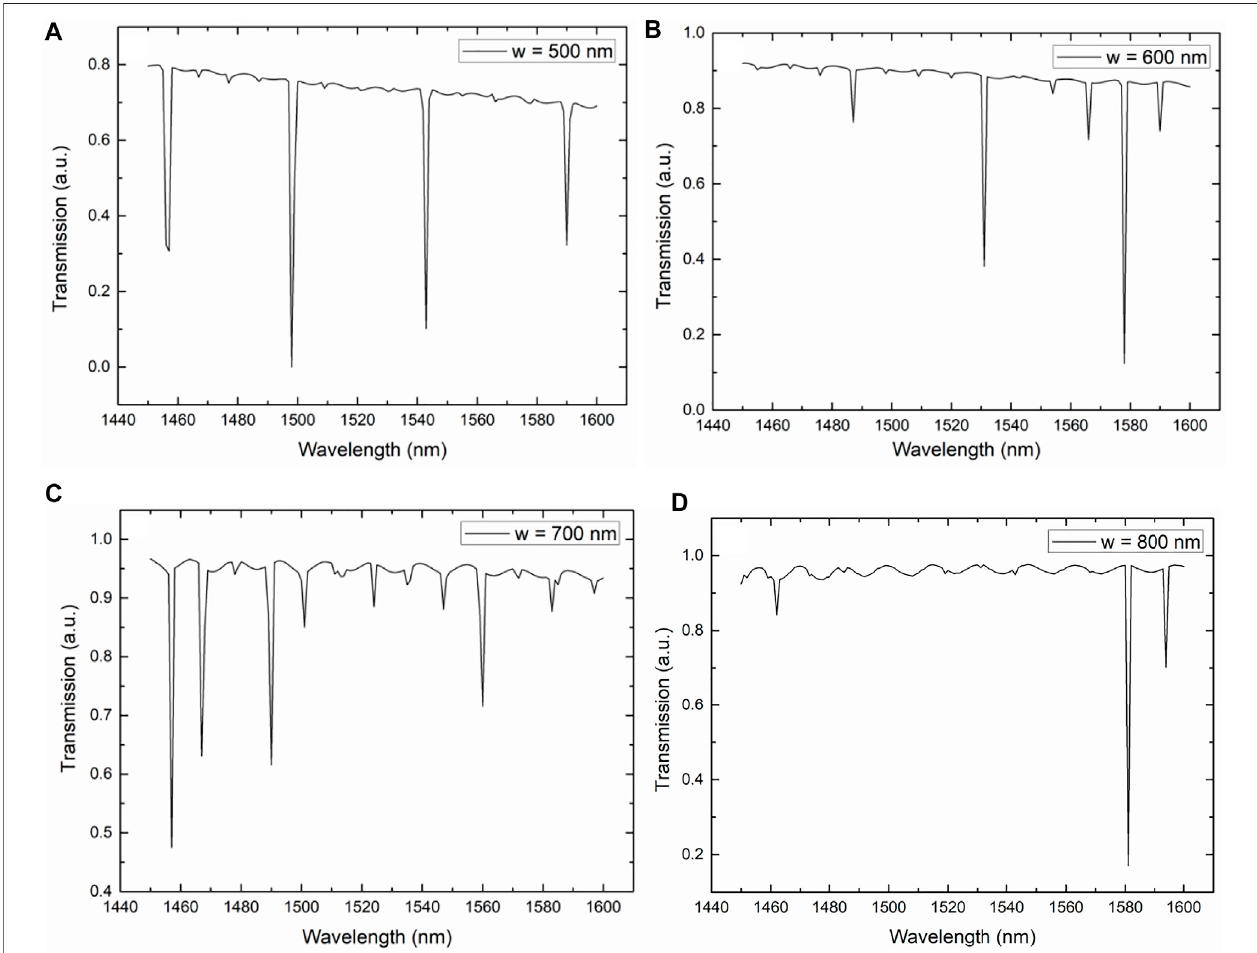
FIGURE 5 | Transmission curve of the sensor for different widths of the ring and waveguide varying from 500 to 800 nm by 100 nm.